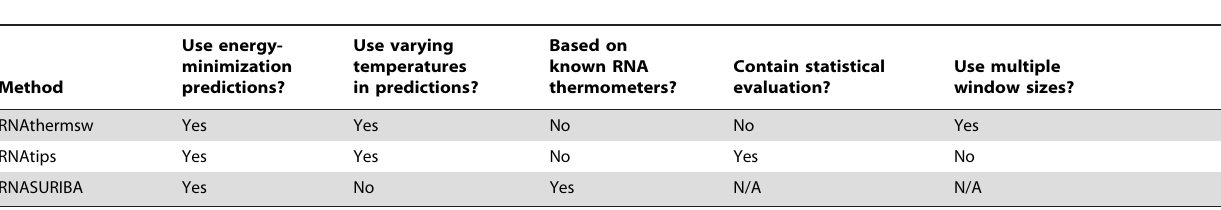
Table 1. Comparison between RNAthermsw, RNAtips, and RNA-SURIBA.